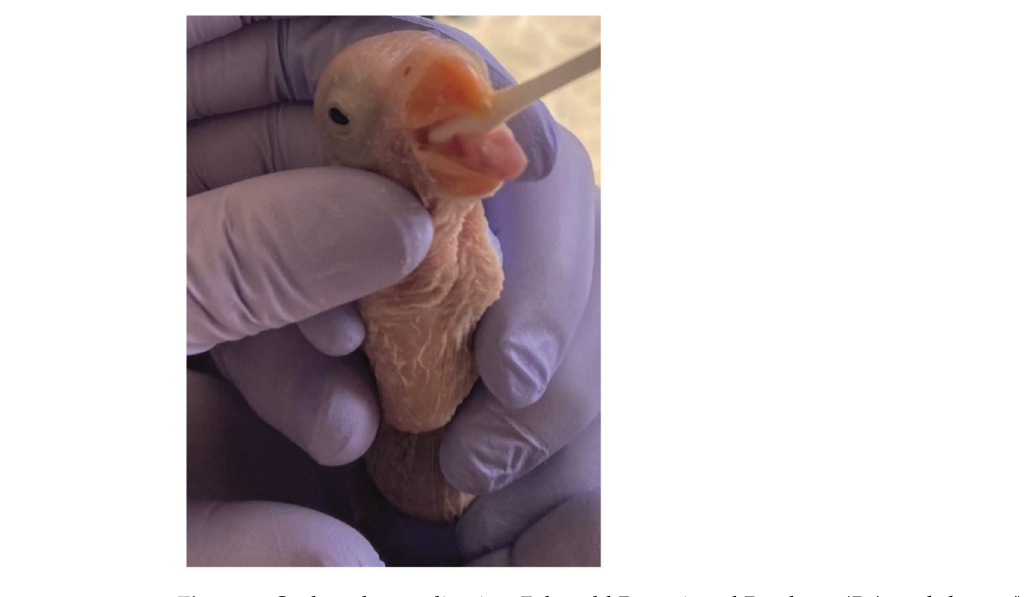
Figure 1. Oral swab sampling in a 7 day old Rose-ringed Parakeet. ( Psittacula krameri